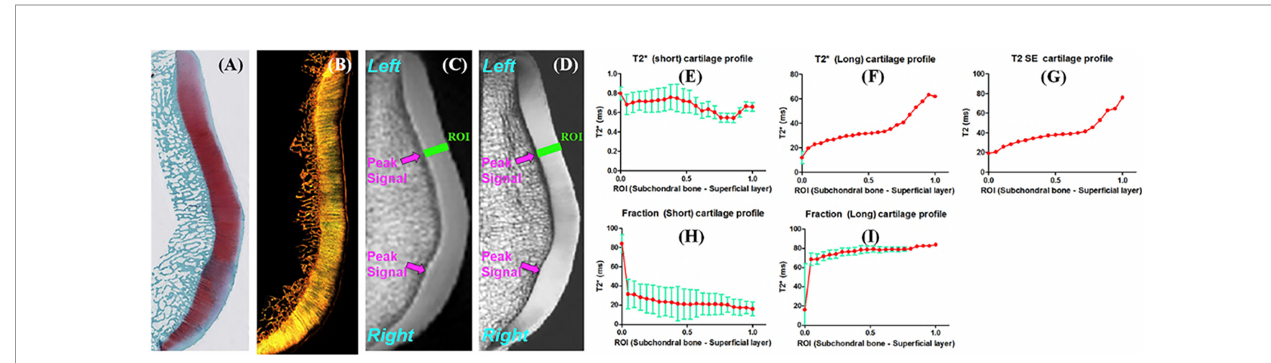
FIGURE 6 | Safranin-O (A) , polarized light microscopy (PLM) (B) , UTE (C) , and PD-SE (D) images of a normal sample of patella donated by a 58 year old male donor. Line pro fi les for short T ∗ 2 (E) , long T ∗ 2 (F) , short fraction (H) , and long fraction (I) , as well as CPMG T 2 (G) are illustrated. Gradual increases in long T ∗ 2 , long fraction, and T 2 from the deep to the super fi cial cartilage is observed. Fitting errors in single component T 2 and bi-component T ∗ 2 analysis are depicted. Peak signal areas corresponding to magic angle on the UTE and SE images are also delineated (arrows). Modi fi ed, with permission from Ref